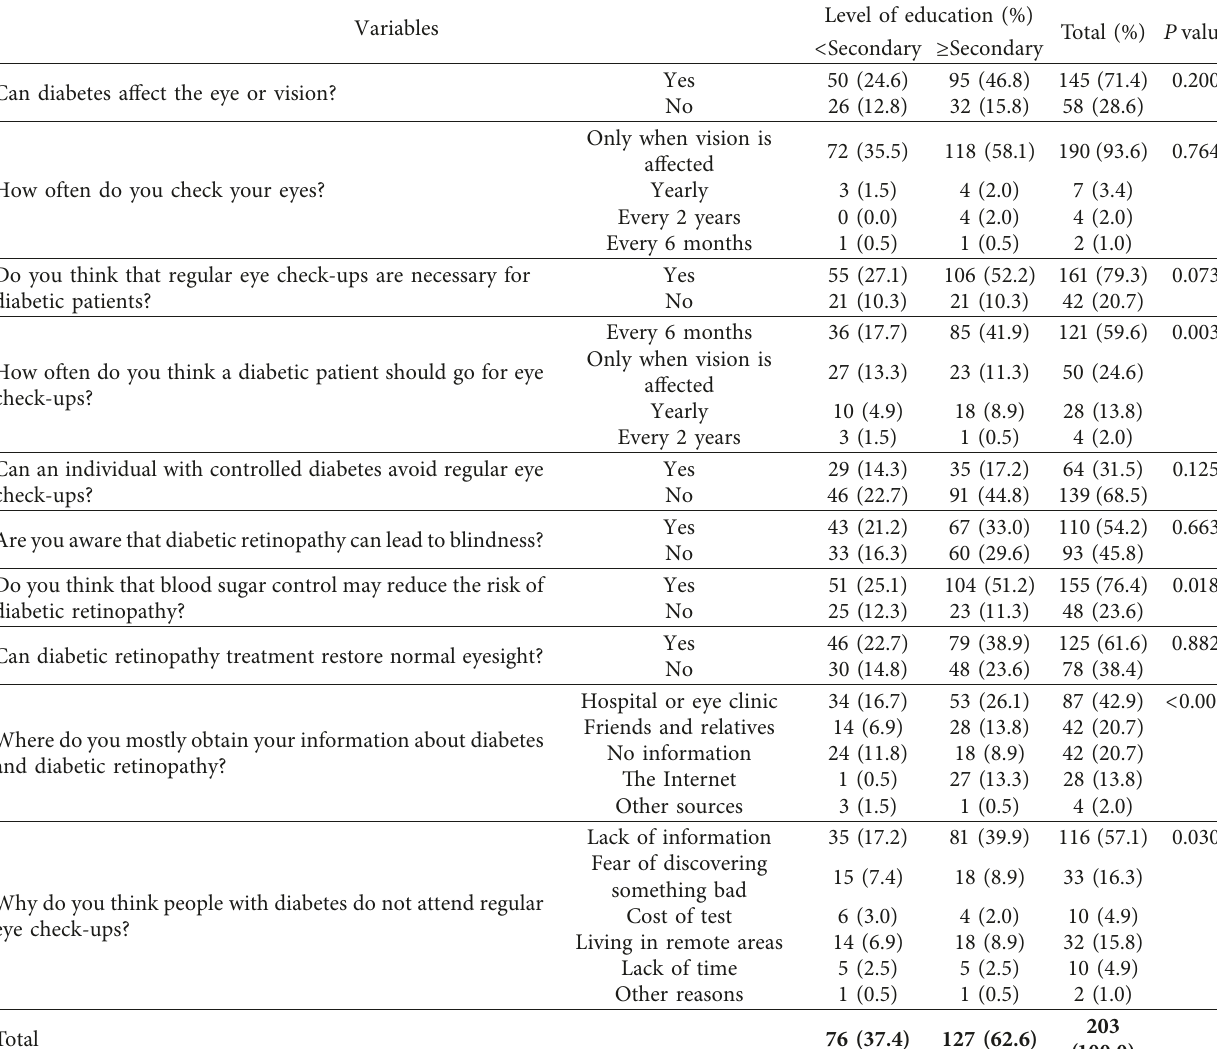
Table 3: Association between level of education of patients and their knowledge and awareness of DM and DR.